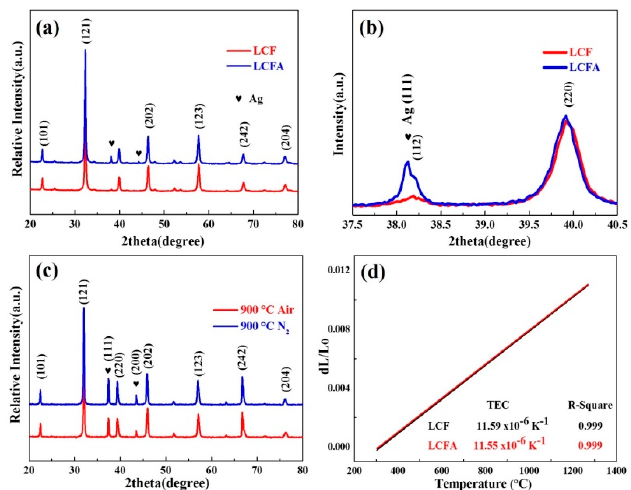
Figure 2. ( a – c ) The powder X-ray diffraction (XRD) patterns of La 0.8 Ca 0.2 Fe 0.94 O 3 − a (LCF) and LCFA. ( a ) Room temperature; ( b ) the magnified characteristic peaks of metallic Ag; (c) high temperature at 900 °C in air or nitrogen of LCFA; and thermal expansion profiles ( d ) of the LCF and LCFA bar samples sintered at 1400 °C from dilatometry (heating rate: 5 °C min − 1 ).